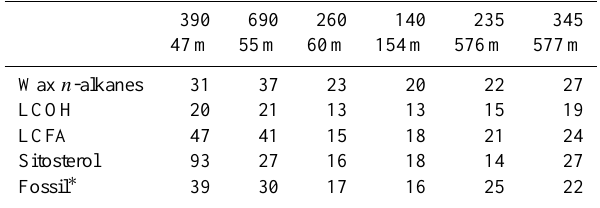
Table 13. Percentage of terrigenous organic carbon with respect to the total organic content of the sediment sample, obtained from the ratio of different terrestrial biomarker concentrations (normalized to total organic carbon) at a given site versus the biomarker concen- trations representative of the